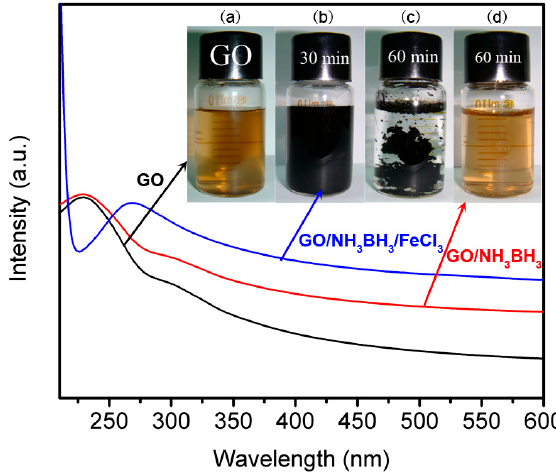
Figure 2. Ultraviolet visible spectroscopy of GO ( a ) and GO/NH 3 BH 3 with ( b for 30 min, c for 60 min) or without ( d ) FeCl 3 during the reduction process. Inset picture is the corresponding photos of the products.